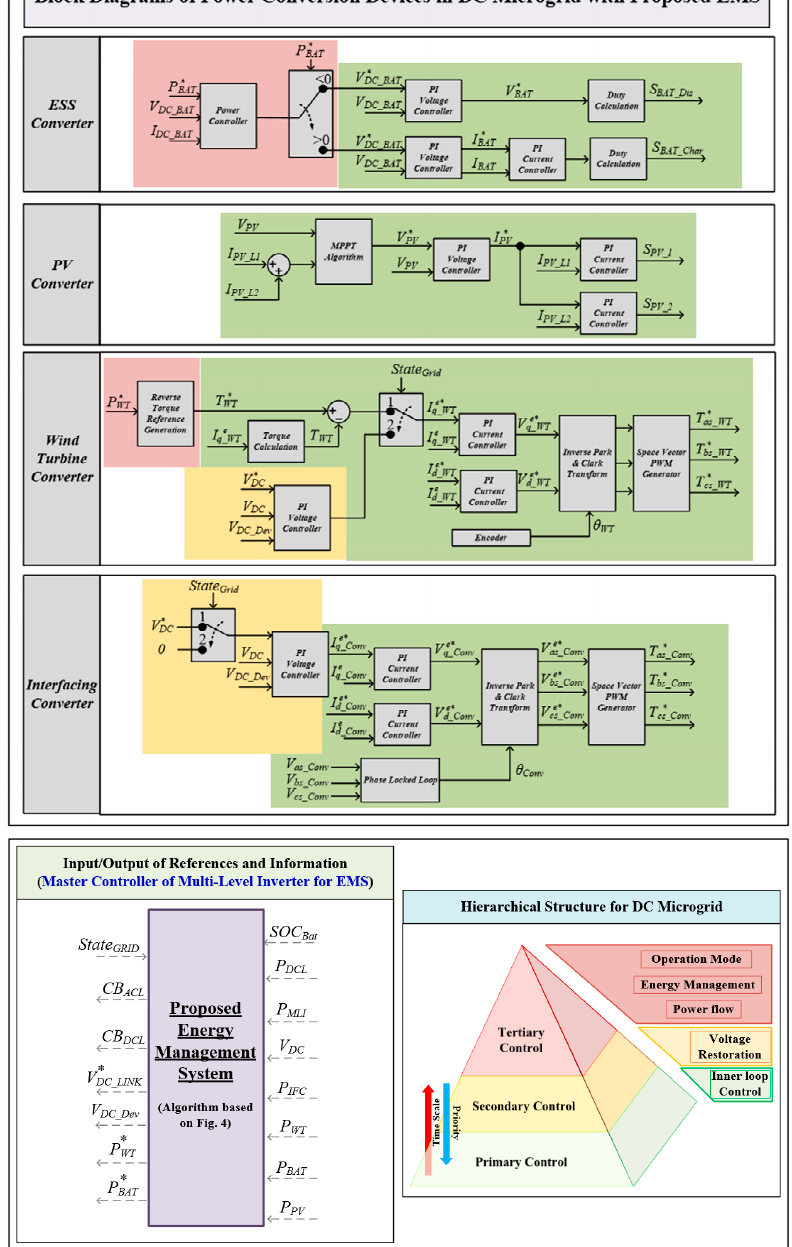
Figure 3. Control block diagram of power conversion devices with proposed EMS